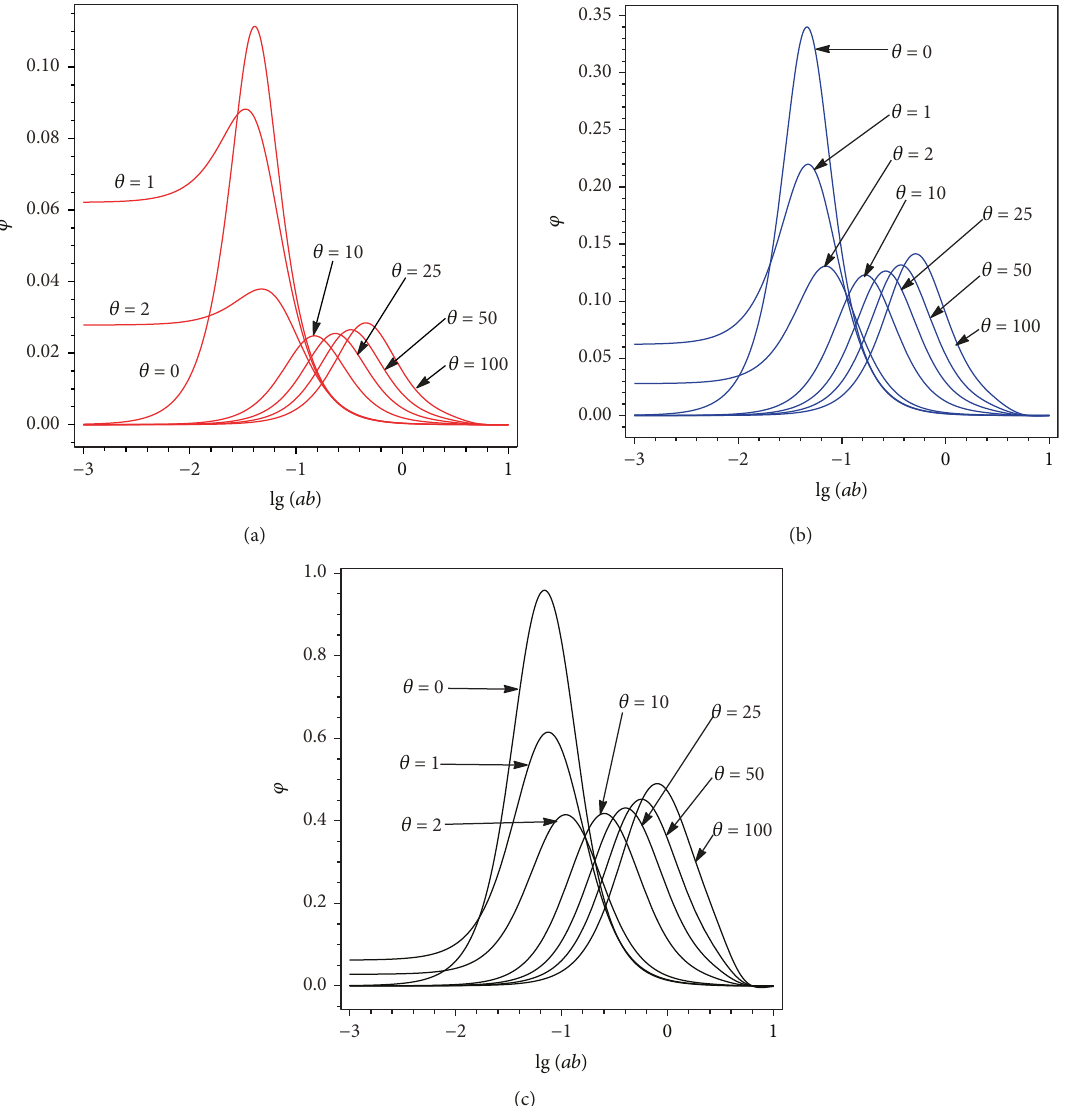
Figure 3: Changes of phase shift φ at the middle of the con fi ned aquifer z = 0 5 b with lg ab for di ff erent values of θ when L 0.8, (b) 0.5, and (c) 0.1. The loading coe ffi cient L